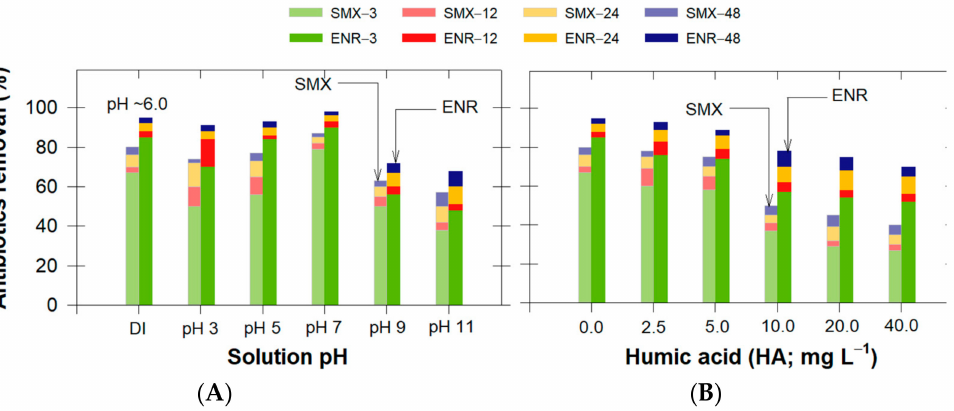
Figure 7. Effect of ( A ) bicarbonate and ( B ) chloride concentrations on SMX or ENR removal efficiency using